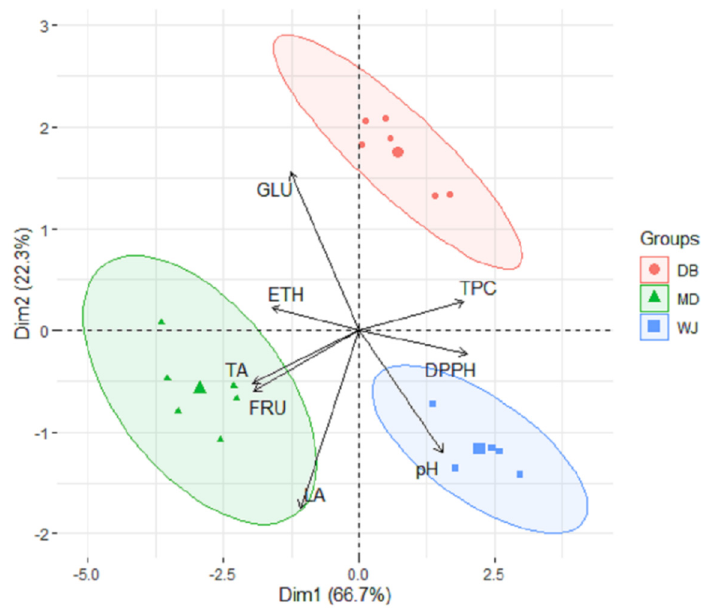
Figure 3. A tb-PCA biplot of key parameters of the particular wines. Abbreviations: ETH-concentration of ethanol, TA-total acidity, TPC-total polyphenol concentration, DPPH-analysis of antioxidant activity, GLU-glucose concentration, FRU-fructose concentration, LA-lactic acid concentration. Biplot was performed using R software.